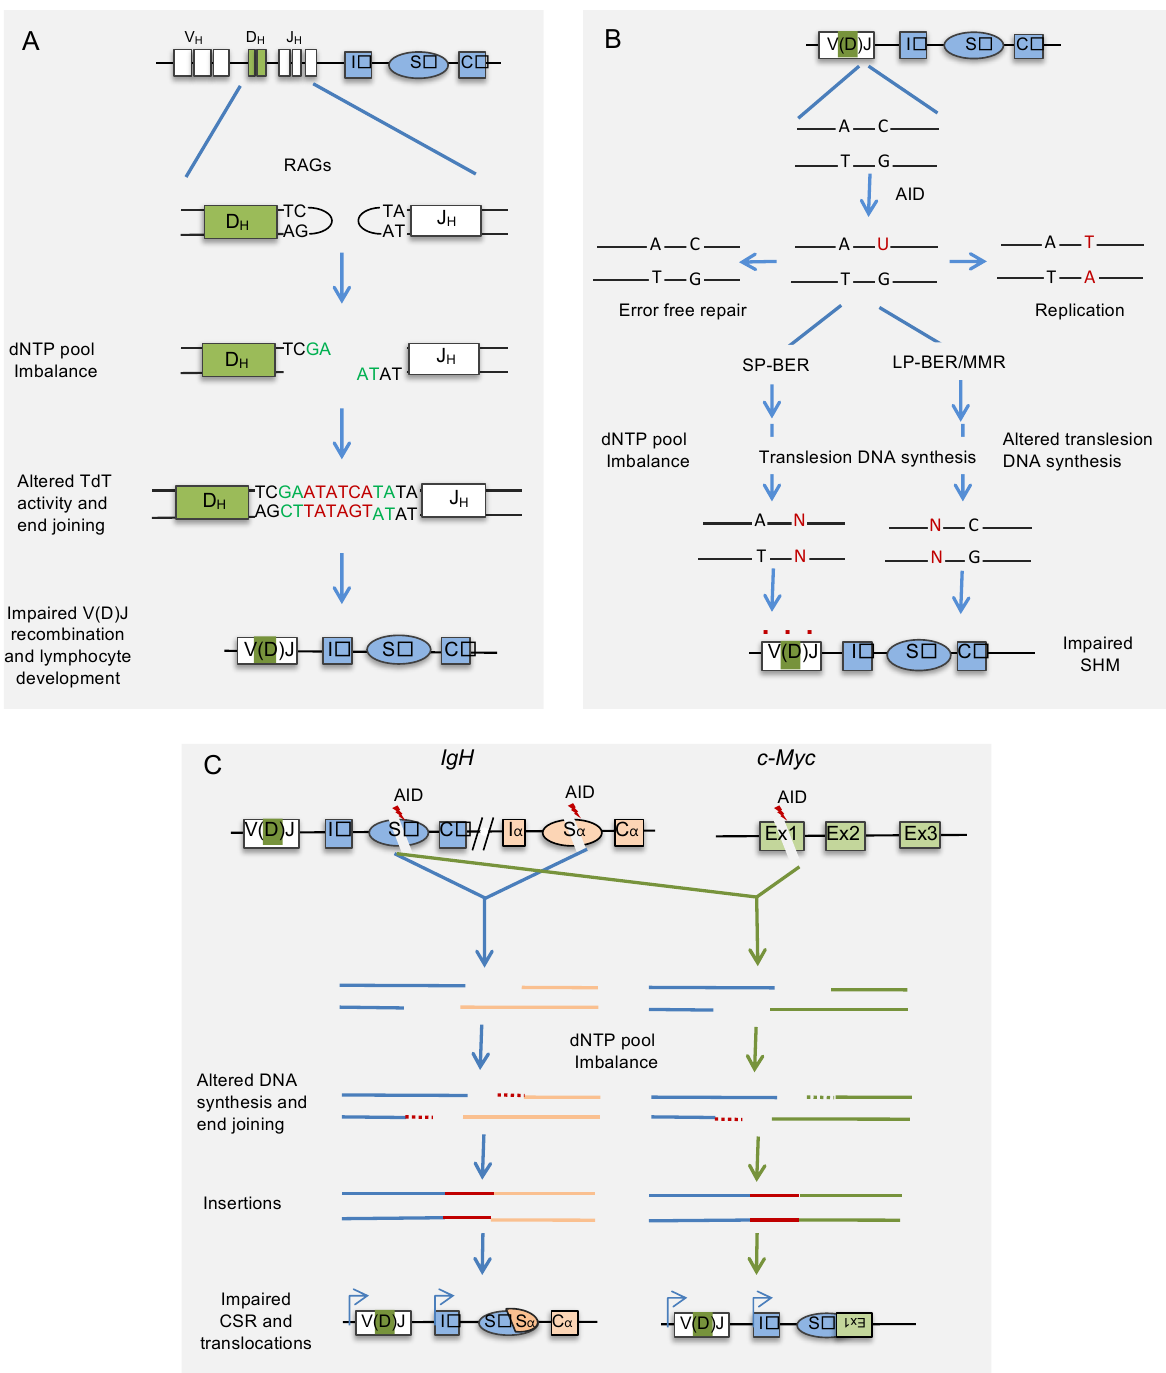
Figure 2. Effect of nucleotide pool imbalance on antibody gene diversification. ( A ) Imbalanced dNTP pool impairs the end-joining of RAG-induced DSBs by altering the activity of TdT, and possibly other DNA polymerases involved in end-joining during VDJ recombination. The red-colored nucleotides at the junction represent N-segment, and green-colored nucleotides represent P-segments. ( B ) The imbalance in the dNTP pool affects the translesion DNA polymerases involved in repairing mismatches produced by AID during hypermutation of recombined V region. ( C ) The dNTP pool imbalance also affects end-joining of AID-induced DSBs during physiological CSR and aberrant chromosomal translocations involving antibody genes. The imbalanced dNTP pool affects the activity of DNA polymerases and possibly other end-joining enzymes, leading to long insertions at the recombination junctions. AID: activation-induced cytidine deaminase; RAG: recombination activating genes; TdT: terminal deoxynucleotidyl transferase; SP-BER: short patch-base excision repair; LP-BER: long patch-base excision repair; MMR: mismatch repair.